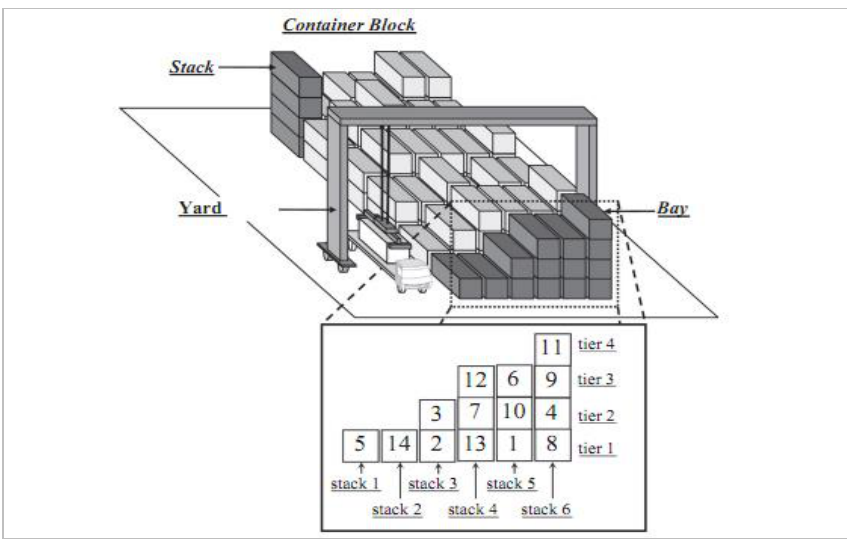
Source : Ting and Wu